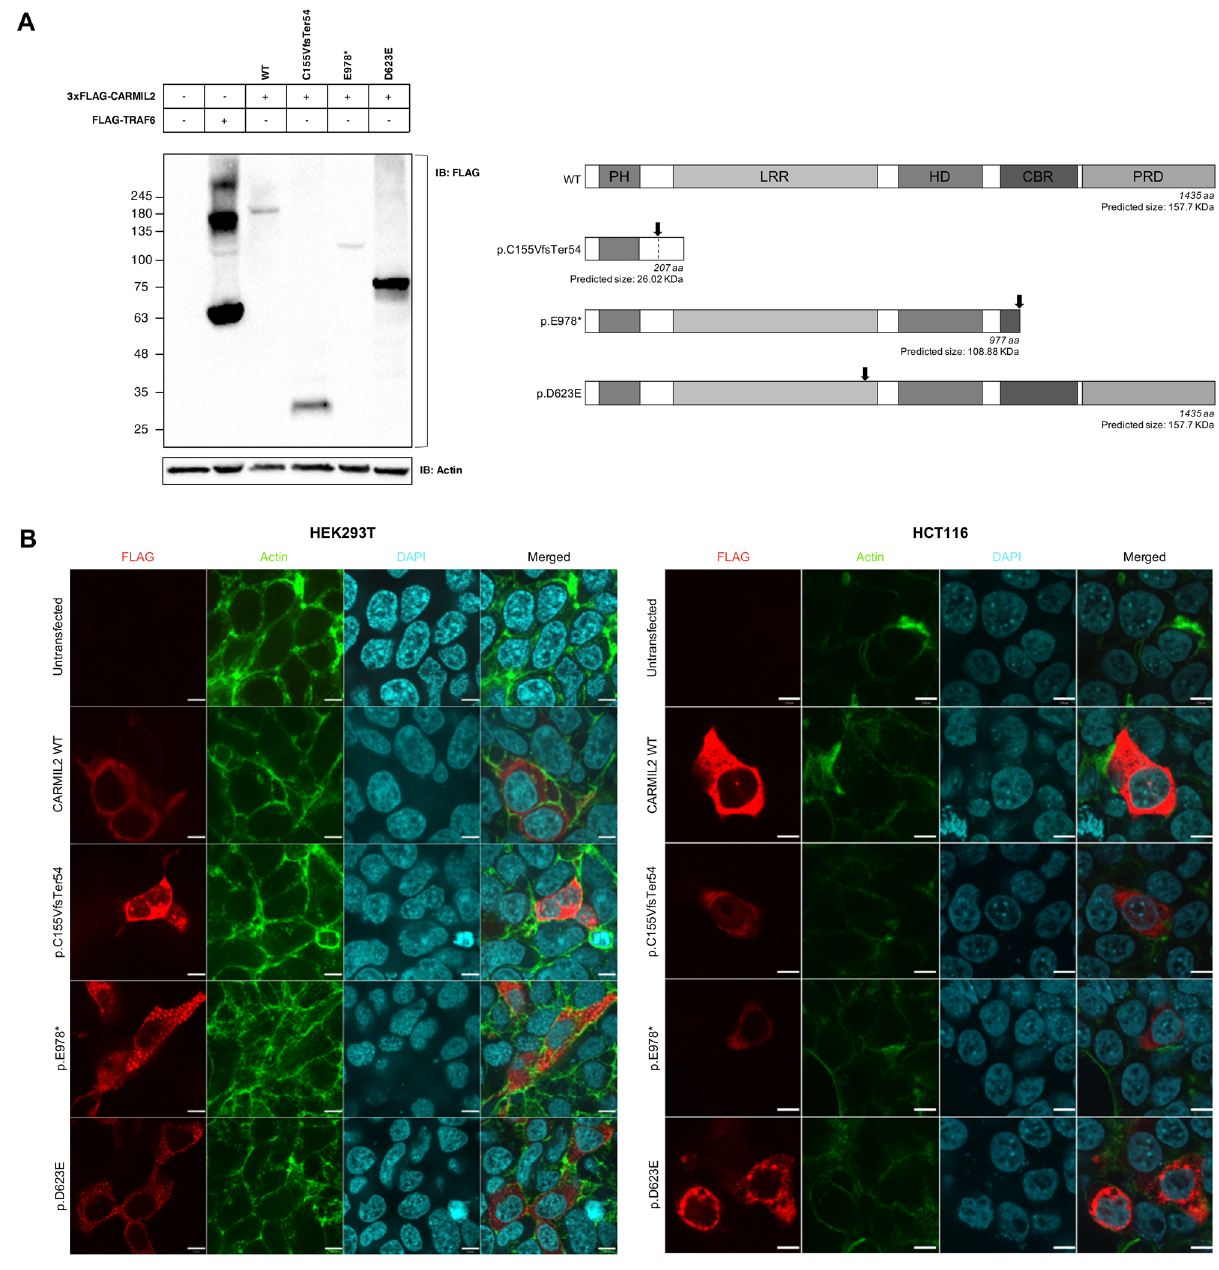
Figure 4. Functional validation of novel CARMIL2 variants. ( A ) Western blot analysis of CARMIL2 expression. Anti-FLAG antibody was used for immunoblotting (left panel). FLAG-TRAF6 served as positive control, β-actin as loading control. The expected molecular weight of CARMIL2 WT and variants (considering the 3xFLAG tag) is shown for comparison (right panel). The black arrow points to the position of the mutation inside the protein. The observed band (~ 180 kDa) of WT CARMIL2 does not correspond to the predicted protein size (~ 155 kDa); this is consistent with what previously reported and with The Human Protein Atlas (available from v19.3.proteinatlas.org) 1,12 . Full-length blots are presented in Supplementary Fig. S2. ( B ) Immunofluorescence staining of HEK293T cells (left panel) and HCT116 cells (right panel) transfected with wild type CARMIL2 or the indicated variants. The first three columns represent the immunofluorescence images of FLAG tagged CARMIL2 (red), actin (green) and nuclei (light blue). The fourth column is a composite image. In HEK293T cells (left panel) CARMIL2 WT and variant p.C155VfsTer54 display a diffuse cytoplasmic expression pattern, while variants p.E978* and p.D623E exhibit a more granular pattern of expression. In HCT116 cells (right panel) expression pattern of all CARMIL2 isoforms is cytoplasmic, although variant p.D623E signal appeared as puncta structures. Scale bar: 7